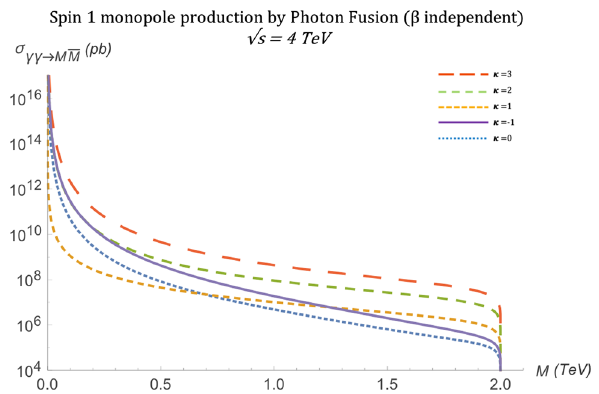
Fig. 16 Totalcrosssectionforthepairproductionofspin-1monopoles via the PF process, as a function of the monopole mass M for different √ s γγ = 4 TeV values of κ at